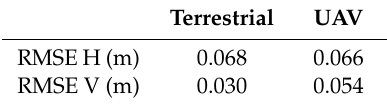
Figure 9. Comparison of the terrestrial and UAV point clouds, computed on 20 checkpoints for Chedi structure. ( a ) Point clouds from TLS. ( b ) Point clouds from UAV.